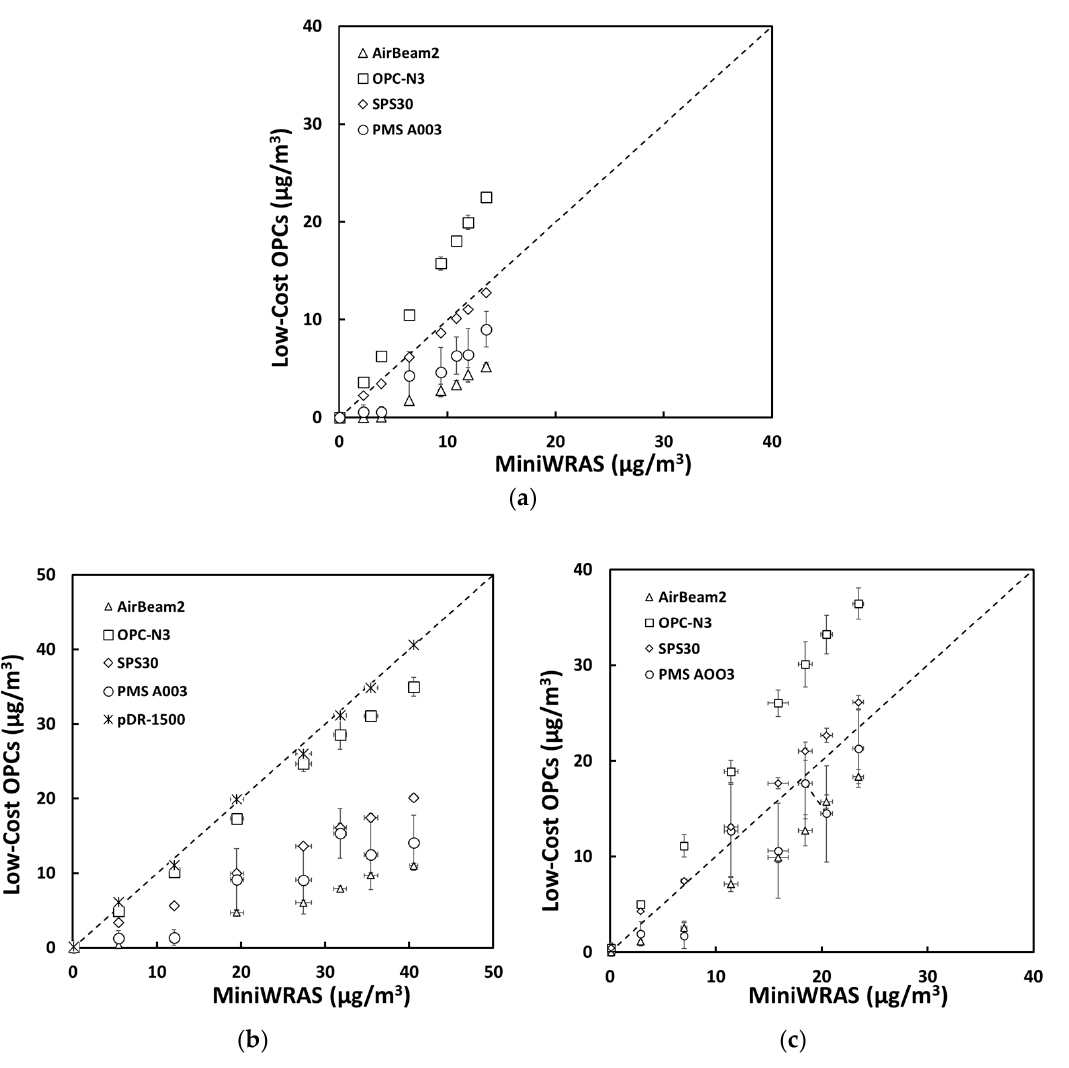
Figure 2. The mass concentrations (µg/m 3 ) of ( a ) PM 1 , ( b ) PM 2.5 mc, and ( c ) PM 10 reported by the sensors plotted against the reference device for the salt environmental experiment.